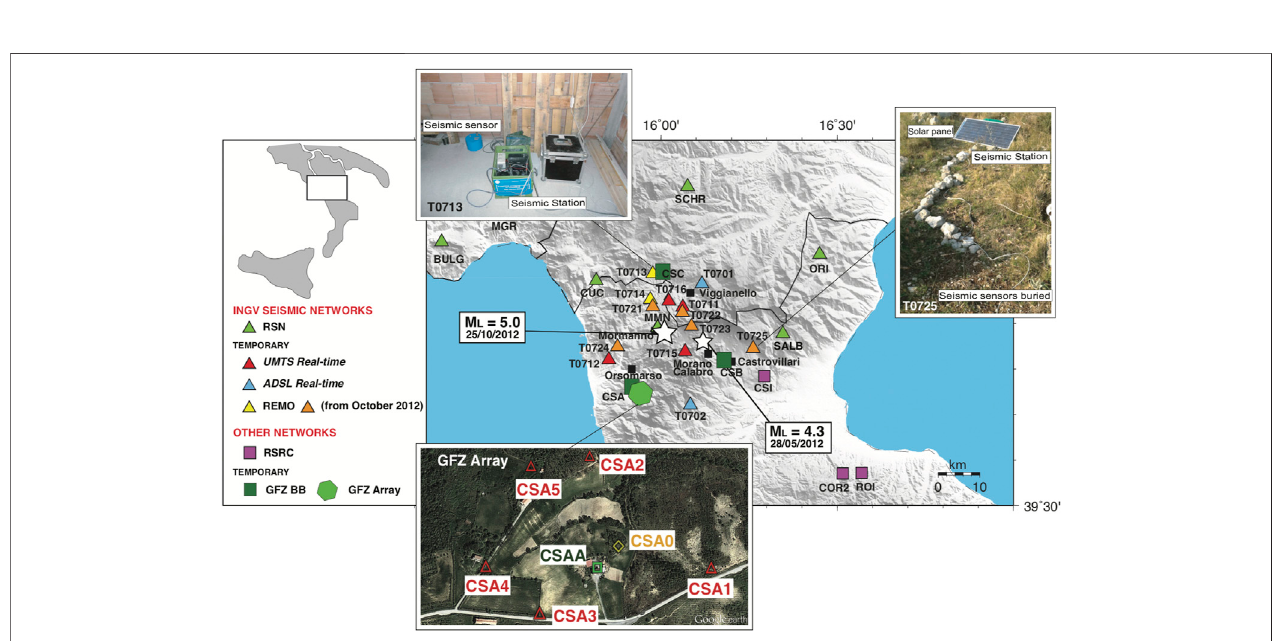
FIGURE 4 | Map of temporary and permanent seismic networks deployed in the area during the seismic activity. In the upper insets an example of installation is reported; in the lower panel is shown the GFZ seismic array con fi guration. In the map, the two main-shocks are also reported as white stars.